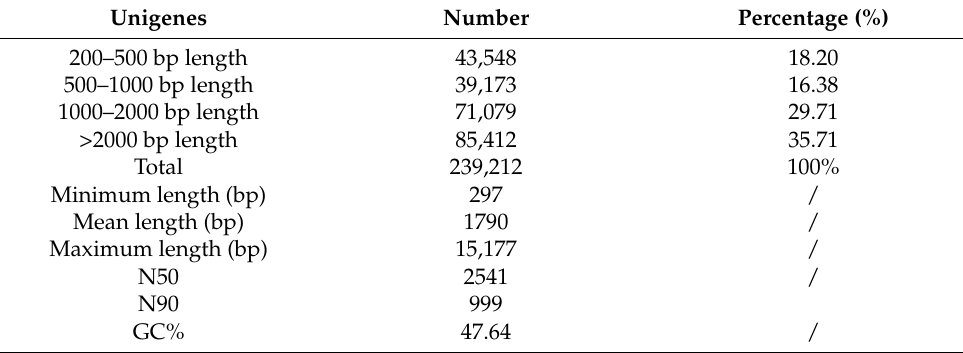
Table 2. Length distribution of assembled